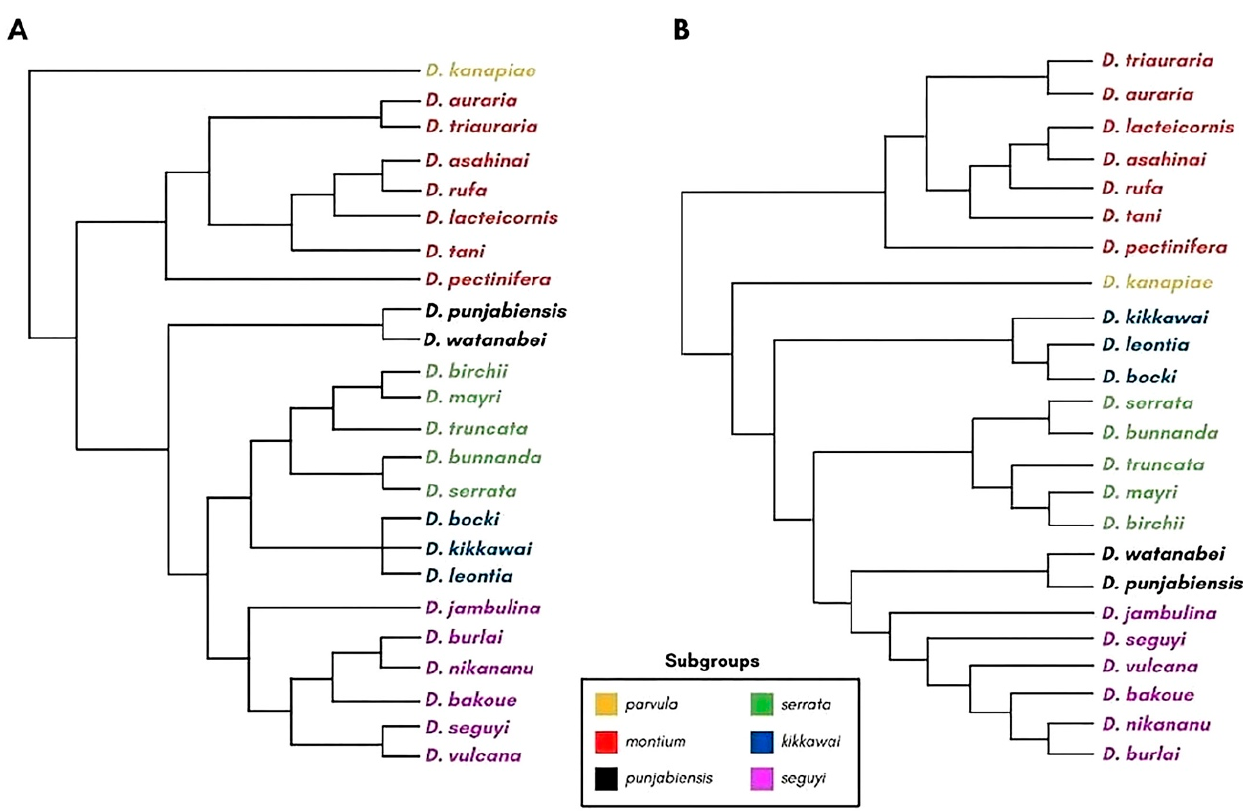
Figure 1. Phylogenetic relationships among subgroups from the montium group. Only the species investigated in the present work are shown. ( A ) Phylogeny based on three nuclear genes and one mitochondrial gene (adapted from Yassin [29]). ( B ) Phylogeny based on 60 genes (adapted from Conner et al. [30]). The branch lengths do not correspond to evolutionary distances. The phylogenetic trees were reconstructed using the Archaeopteryx software [31].